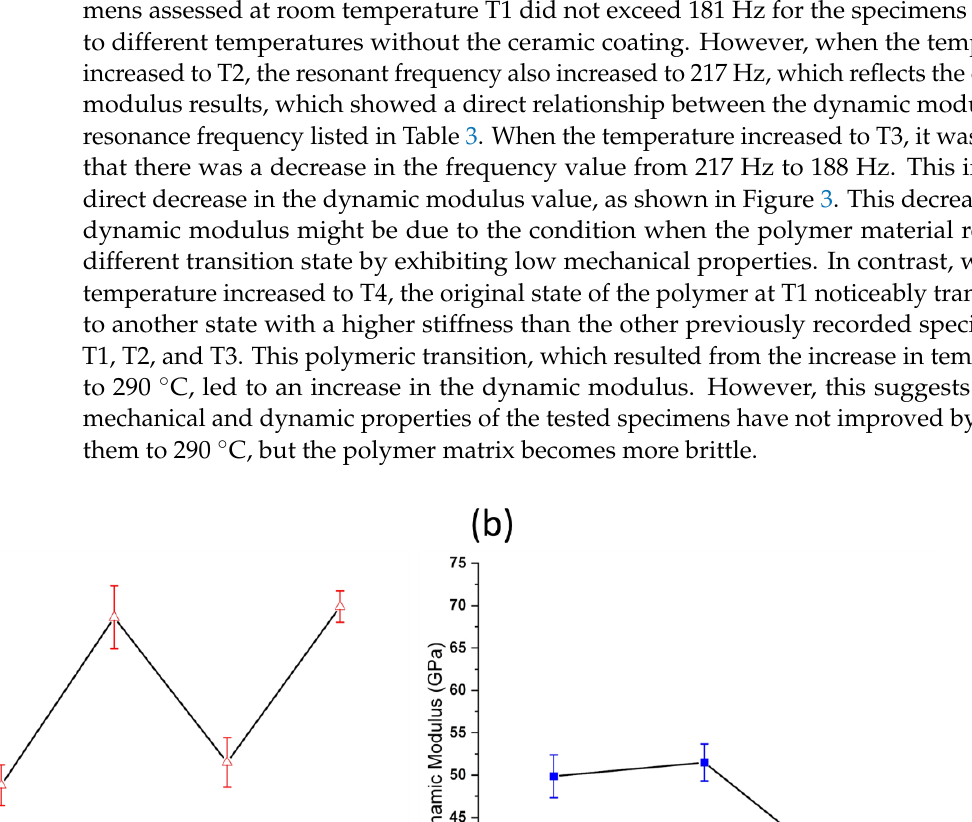
Table 3. The dynamic properties of the tested specimens.